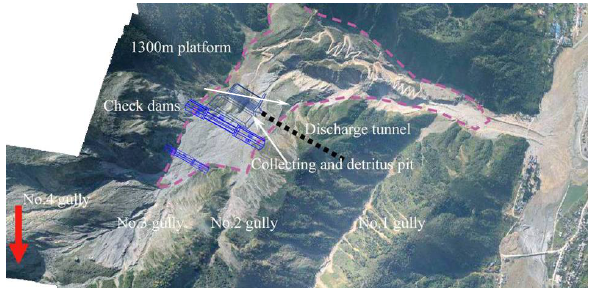
Fig. 18. Check dam destroyed by the 8.13 debris flow near the outlet of the Wenjia Fig. 19. An overview of the Wenjia gully debris flow and the reme- Fig. 19. An overview of the Wenjia gully debris flow and the remedial works. dial works. gully.